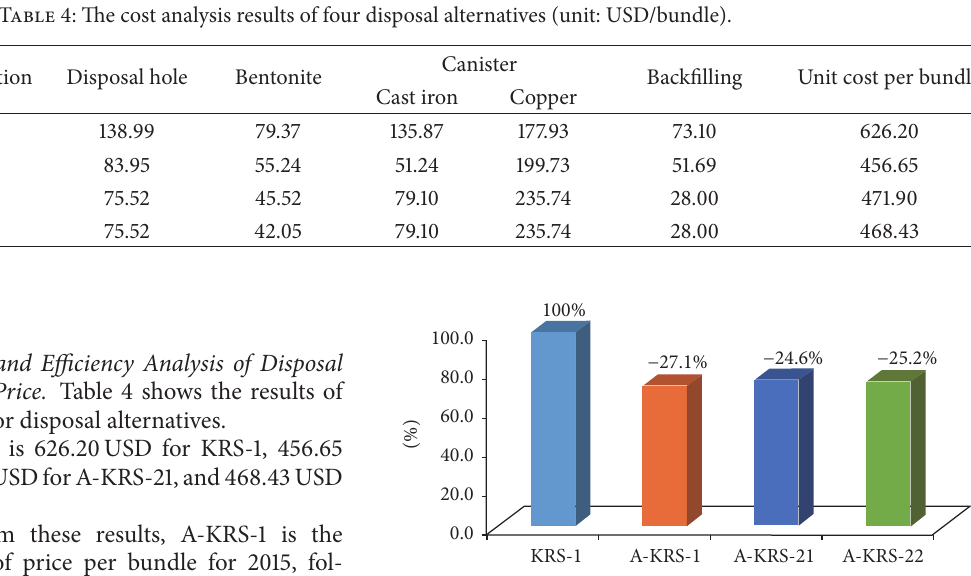
Figure 2: The cost efficiency of disposal alternatives—the price of 2015